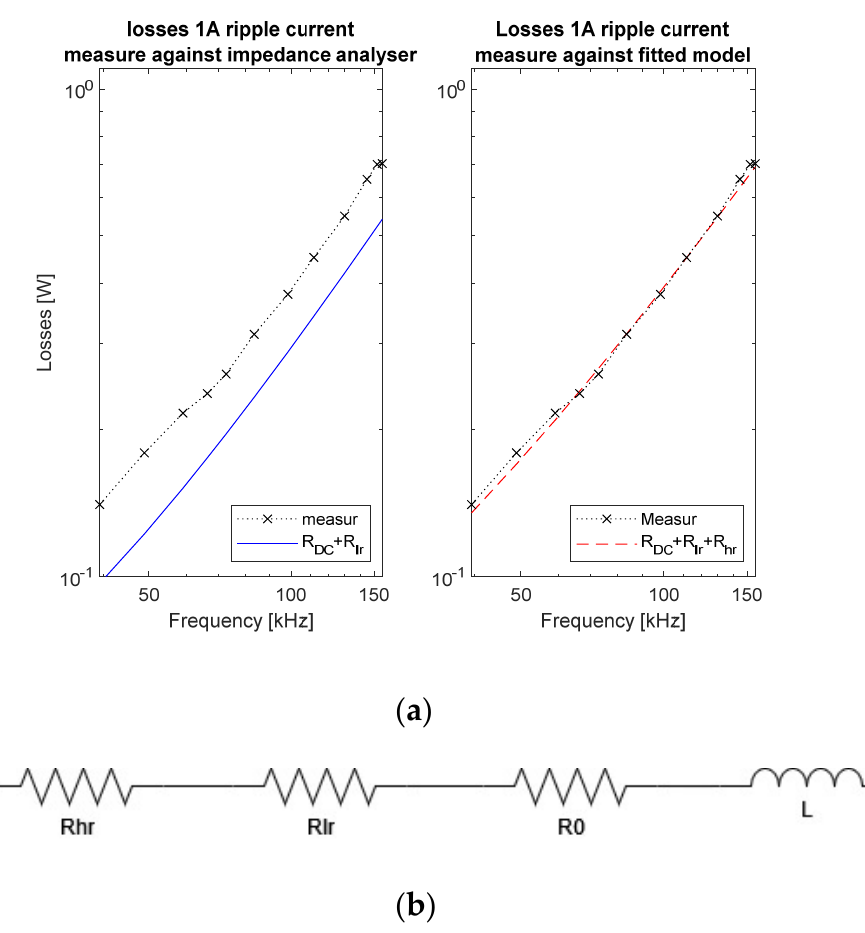
Figure 8. ( a ) Evolution of the power losses in the inductor under test for a frequency range from 50 kHz to 150 kHz. Left, comparison of the losses between the AC losses measure and the model described with Equation (5). Right comparison of the losses between the measure and the model described in Equation (7). ( b ) Equivalent impedance model of the inductor under test.